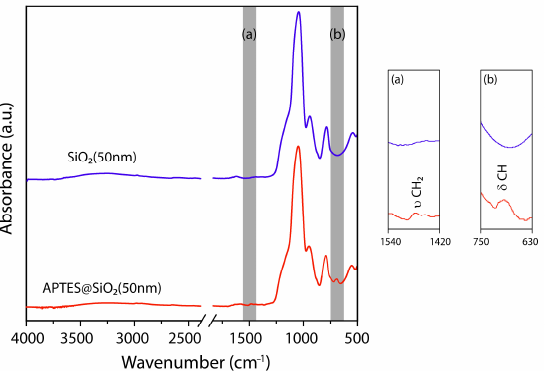
Figure 5. IR spectra of 50 nm size SiO 2 nanoparticles, before (blue) and after (red) APTES functionalization. (insets) zoomed-in FTIR spectra of the vibrational modes of –NH 2 and –CH 2 ( a ), and –CH ( b ).